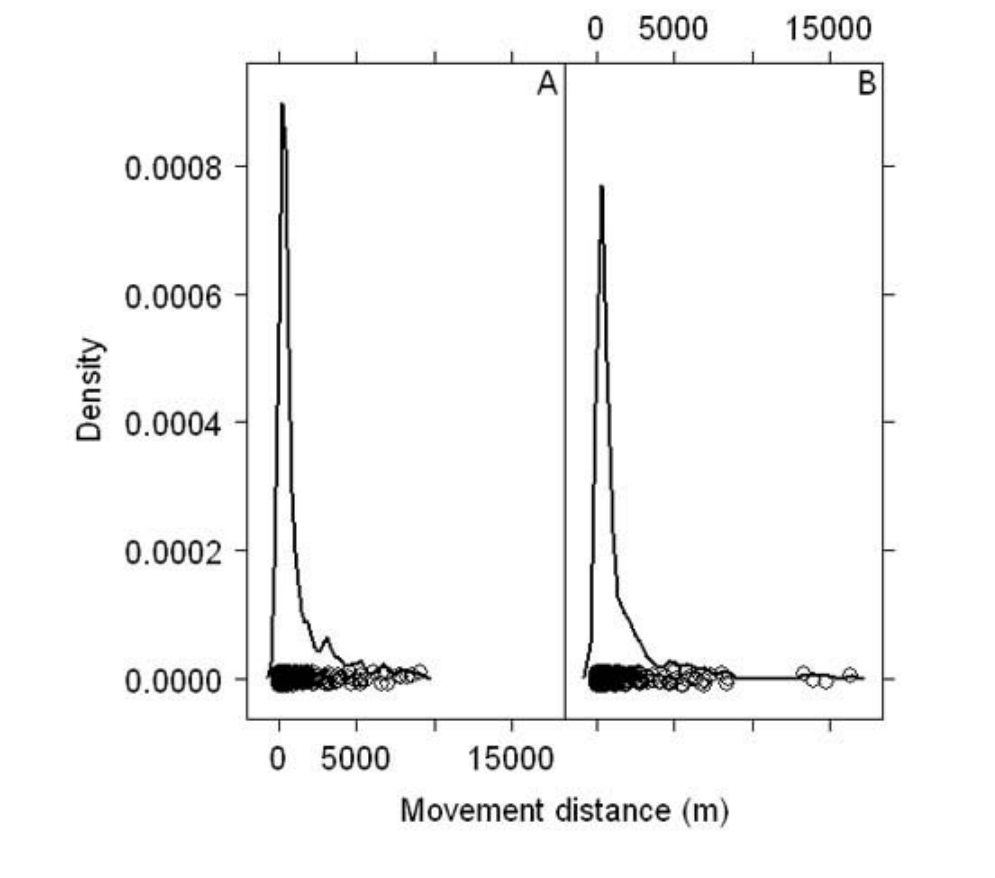
Fig. 3. Density and rug plots illustrating movement distance distributions for (A) Blackpoll and (B) Yellow-rumped Warblers. Density represents the relative proportion of observations for a given movement